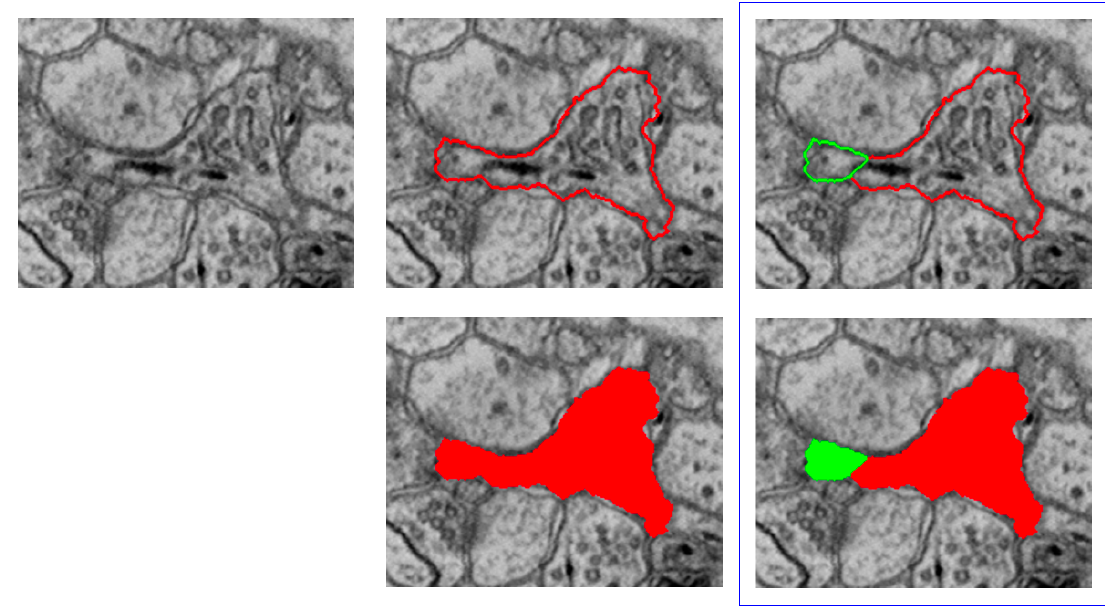
Figure 7. The Guided Proofreading system reduces the time spent finding potential errors by proposing candidate errors and corrections. ( a ) The system is informed by a convolutional neural network (CNN) with a traditional architecture. The CNN uses a patch of image data, membrane probability, binary cell mask, and cell border overlap to decide whether a split error between two neurons exists. ( b ) Then, we present the proofreader with a stream of regions and candidate corrections. Thus, proofreading can be hastened with a series of yes/no decisions, which is about 6 × faster than using